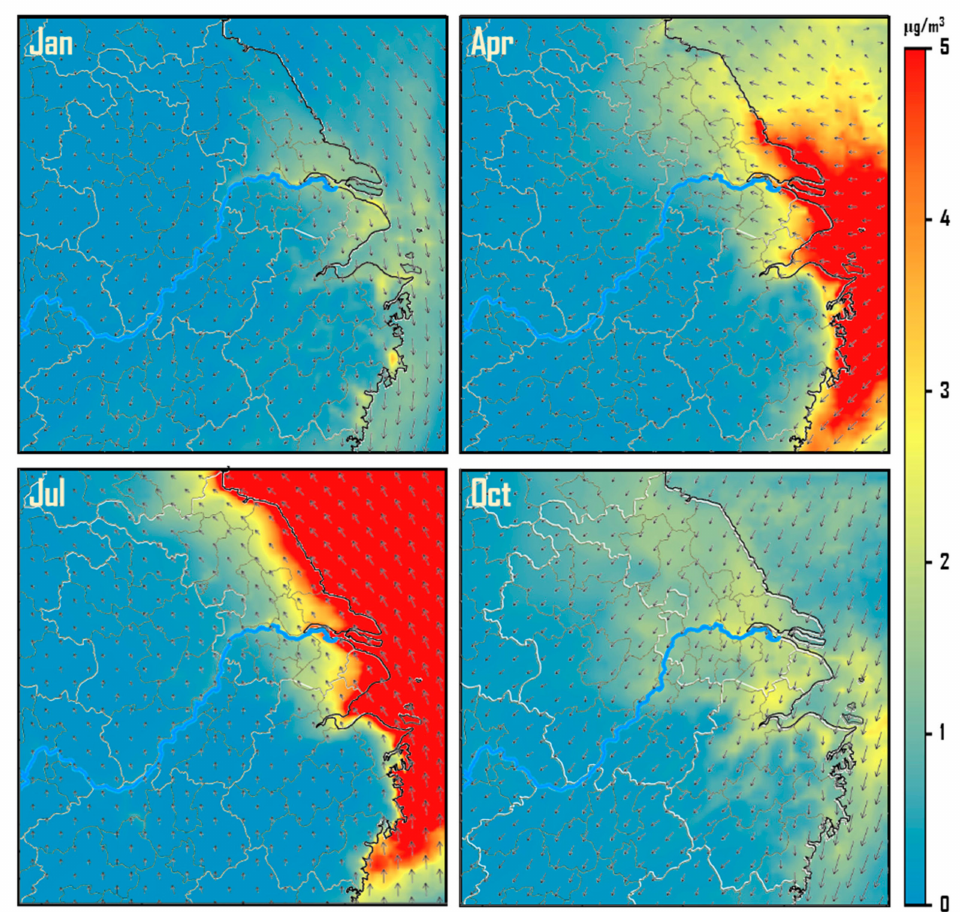
Figure 5. The 10-year average contribution of ship emissions ( µ g/m 3 ) to PM 2.5 overlapped by wind vectors in YRD region in January, April, July and October, which represent the four seasons of winter, summer, fall and spring,